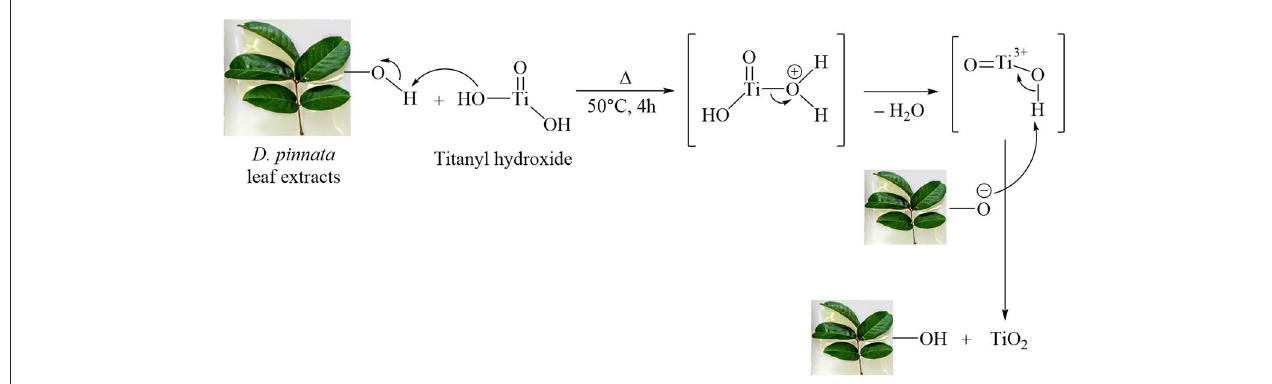
FIGURE 3 | Possible reaction mechanism for the formation of TiO 2 NPs in presence of hydroxyl group (–OH) of leaf extract of D. pinnata .